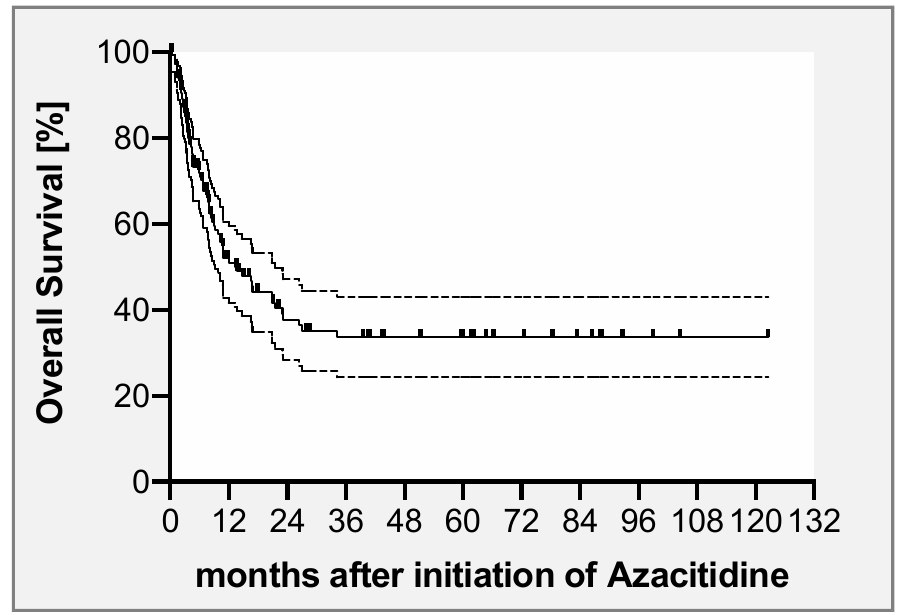
Figure 1. Overall survival (OS) after treatment with azacitidine ± DLI for relapse of myeloid neoplasms. OS of the study population comprising 151 patients was 38% (±9%) at 2 years.